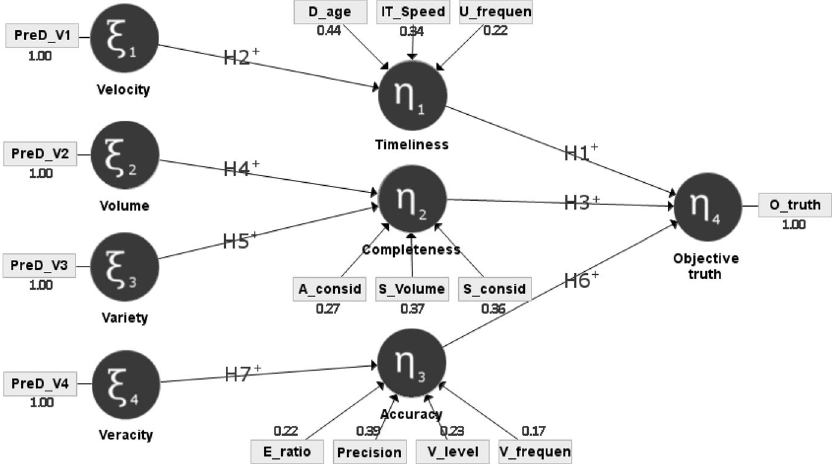
Fig. 2 Derived structural equation model with measurement